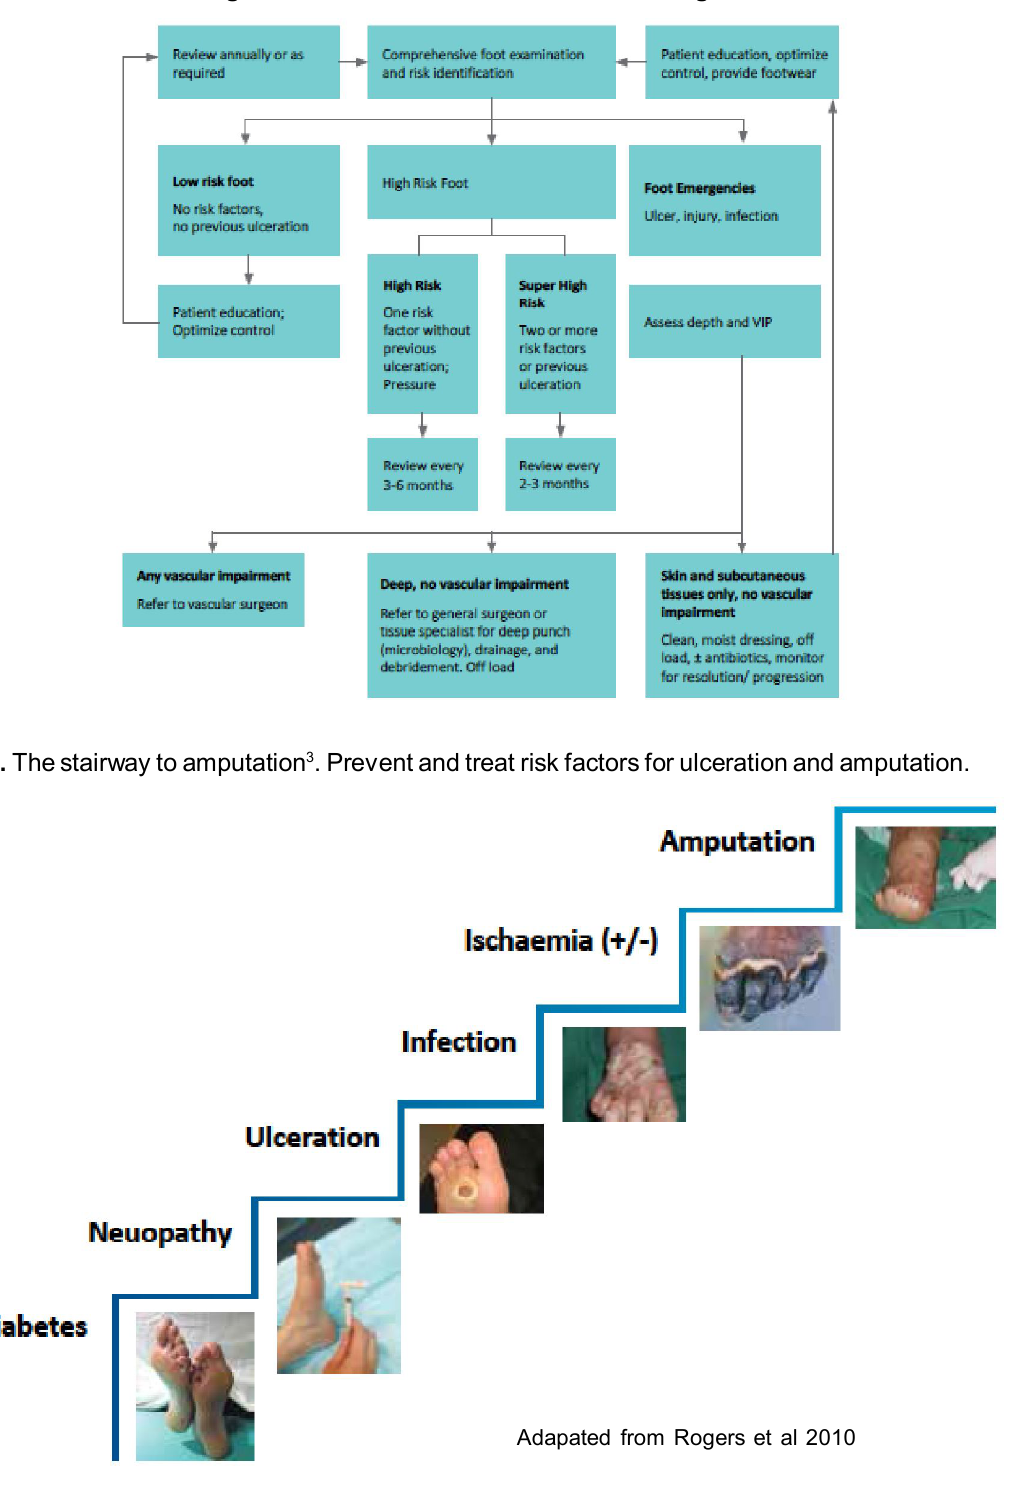
Figure 3. Flowchart of diabetic foot management